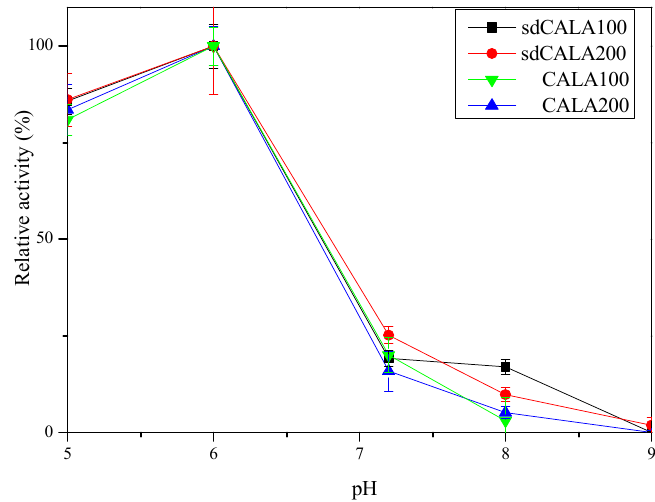
Figure 5. E ff ect of pH on the relative activities of CALA and sdCALA samples prepared at di ff erent shaking